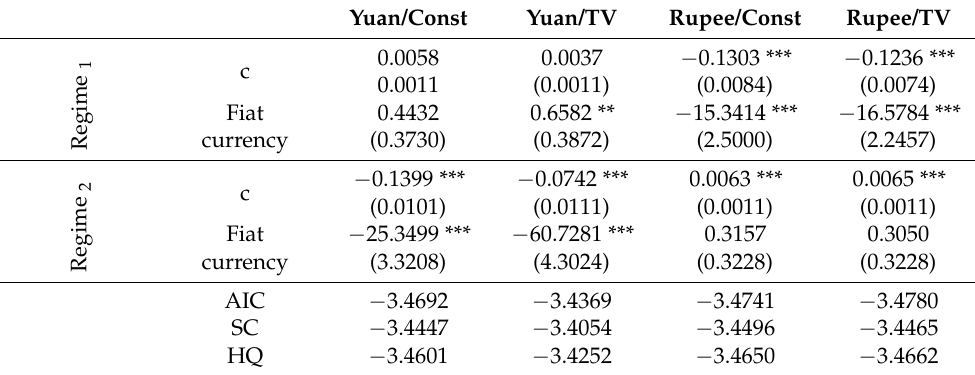
Table 6. MRSR Analysis Results.